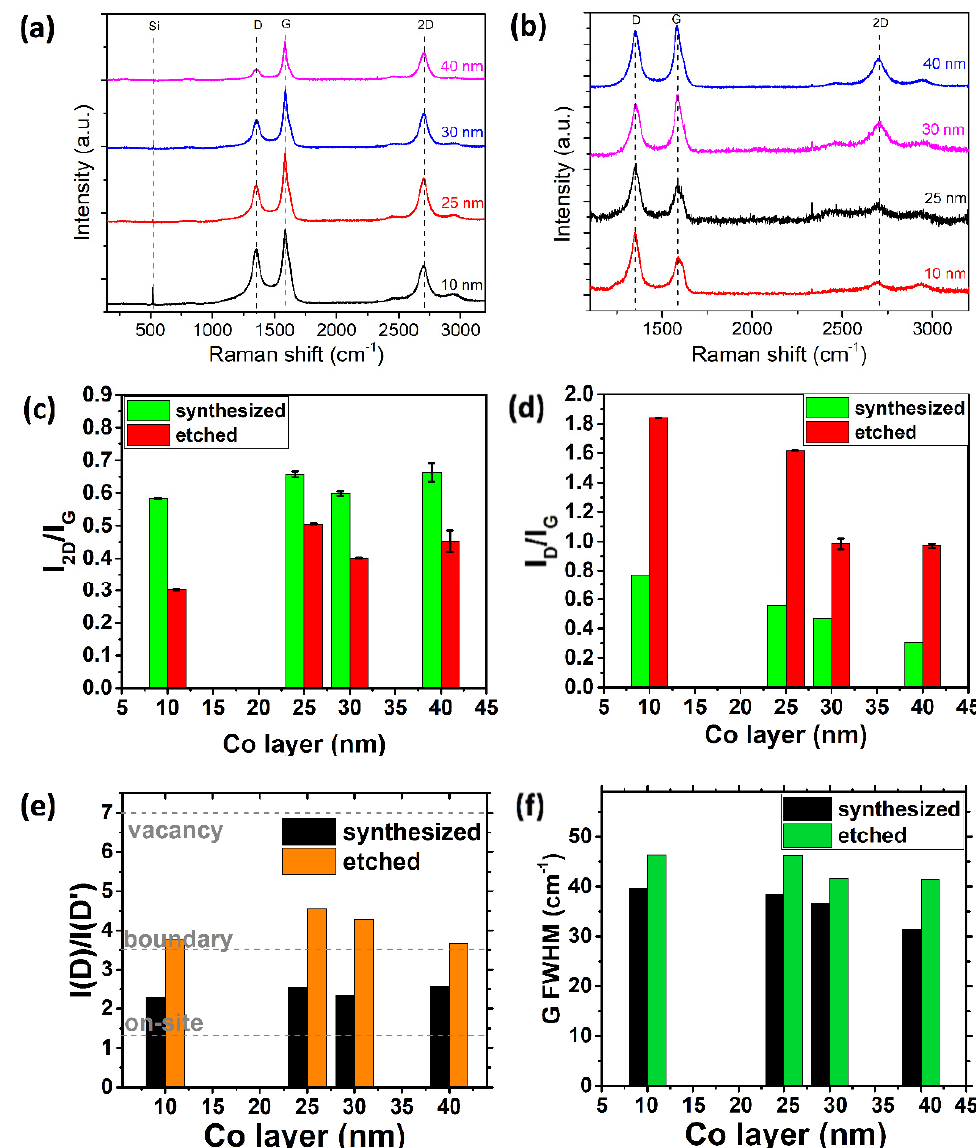
Figure 6. The Co sacrificial layer thickness effects on the structure of graphene grown by a two- step synthesis: the Raman spectra after the synthesis ( a ) and after removing the sacrificial cobalt interlayer ( b ); Raman spectra parameters analyzed: I 2D /I G ( c ); I D /I G ( d ); I D /I D’ ( e ); FWHM(G) ( f ). The synthesis time was 15 min., ion beam treatment temperature—400 ◦ C, annealing temperature— 700 ◦ C, ion beam energy—800